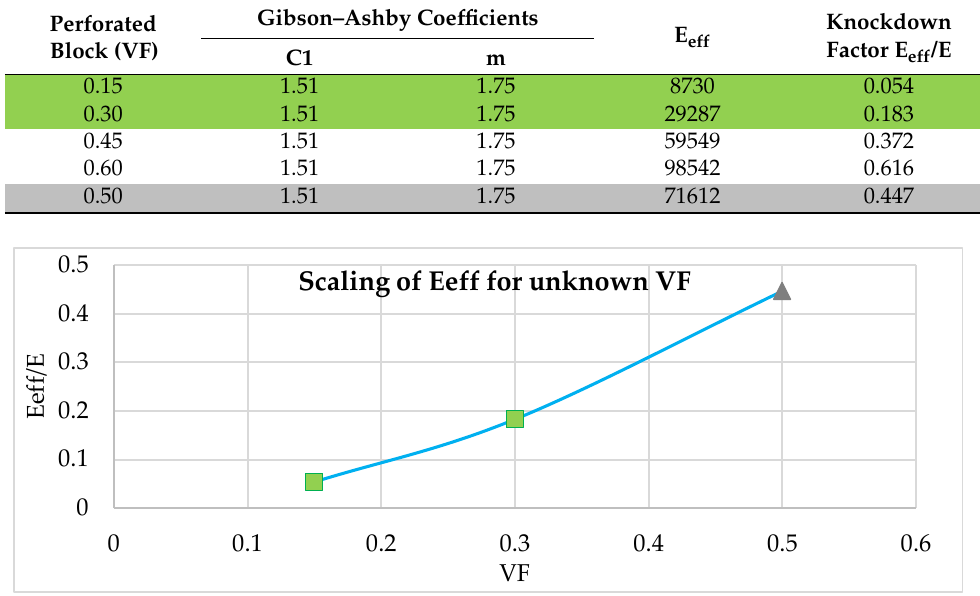
Figure 19. Effective property of scaled effective property using the Gibson–Ashby model. Table 5. Scaling relation using the Gibson–Ashby model for perforated block support.